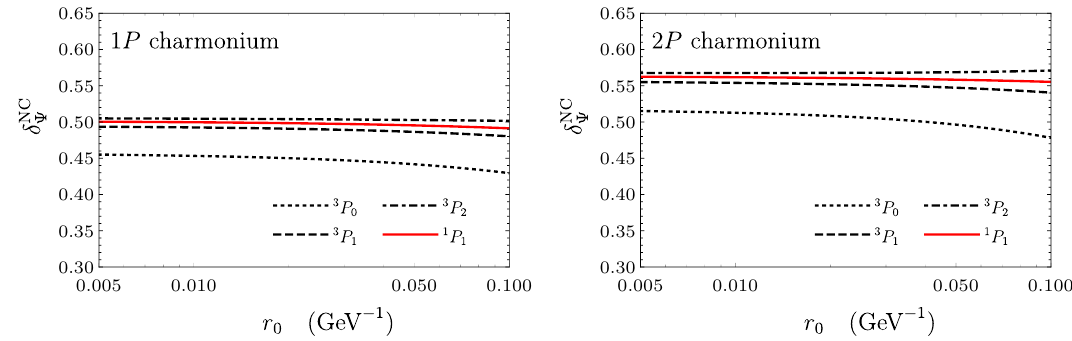
Figure 2 . Non-Coulombic corrections δ NC at finite r 0 for the charmonium 1 P (left panel) and Ψ 2 P (right panel) states, for angular momentum quantum numbers 3 P 0 (dotted lines), 3 P 1 (dashed lines), 3 P 2 (dot-dashed lines), and 1 P 1 (red solid lines). The r 0 dependences are mild for the range r 0 < 0 . 02 GeV − 1 that we